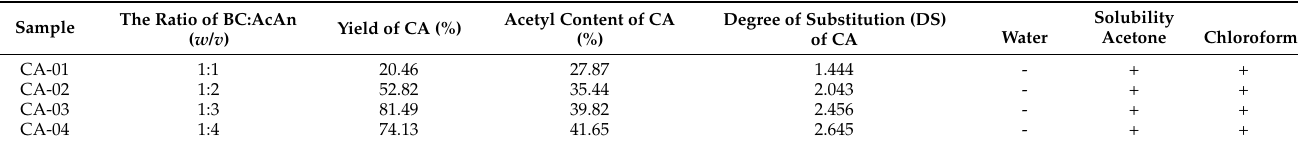
Table 3. Percentage of yield, acetyl content, and DS of